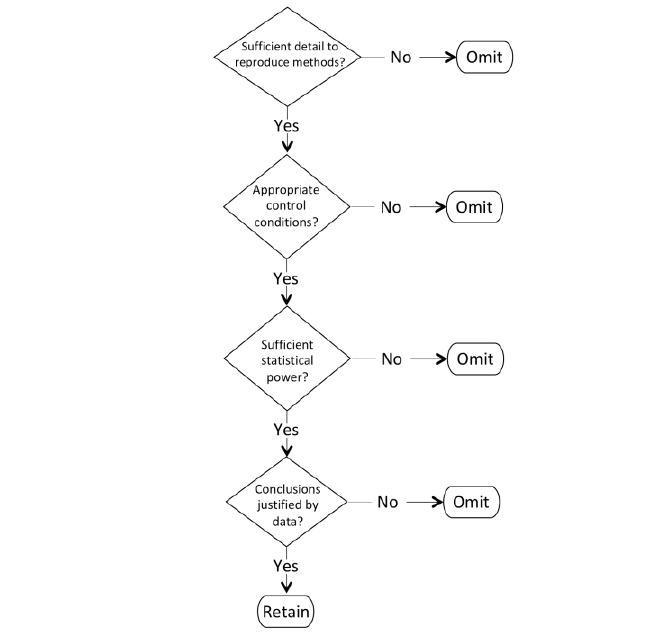
Brain Sci. 2020 , 10 , 215 Figure 2. Flowchart for assessing the quality of papers. Figure 2. Flowchart for assessing the quality of papers.